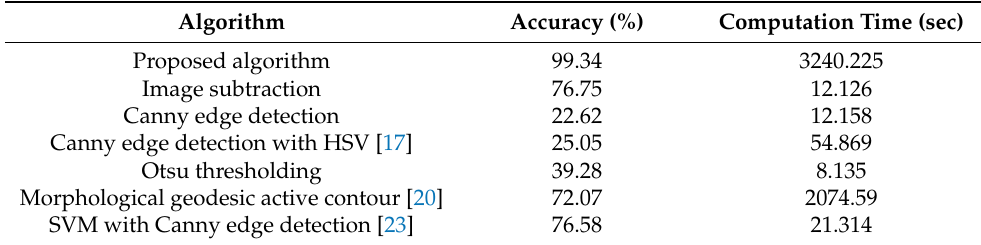
Table 3. Classification accuracy and computation time of the proposed and comparison algorithms.